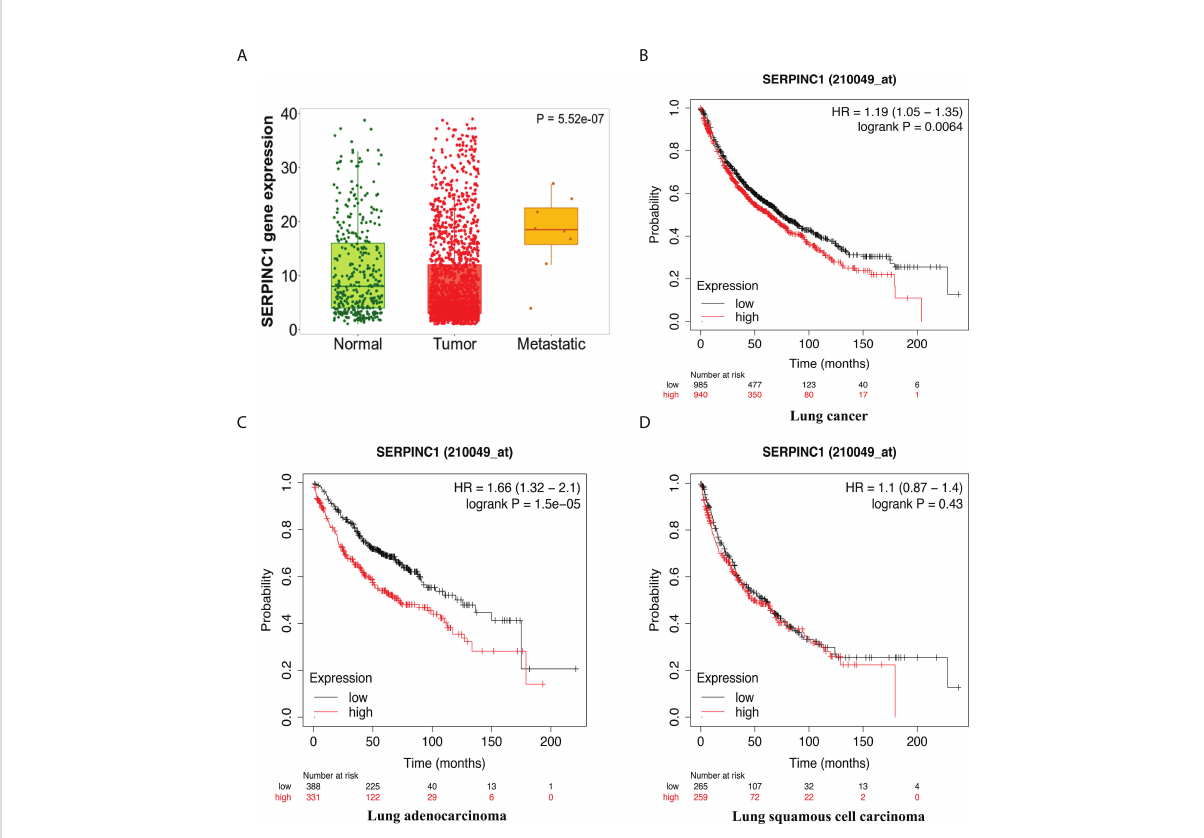
FIGURE 6 The clinical outcomes of high Serpinc1 gene expression in public databases. (A) Comparisons of Serpinc1 gene expression in normal ( n = 391), tumor ( n = 1,865), and metastatic tissues ( n = 8) in lung cancer patients using one-way ANOVA followed by Dunnett ’ s multiple comparisons. Kaplan – Meier survival analysis of OS according to Serpinc1 expression level in (B) lung cancer patients ( n = 2,437), (C) lung adenocarcinoma patients ( n = 719), and (D) lung squamous cell carcinoma patients ( n =